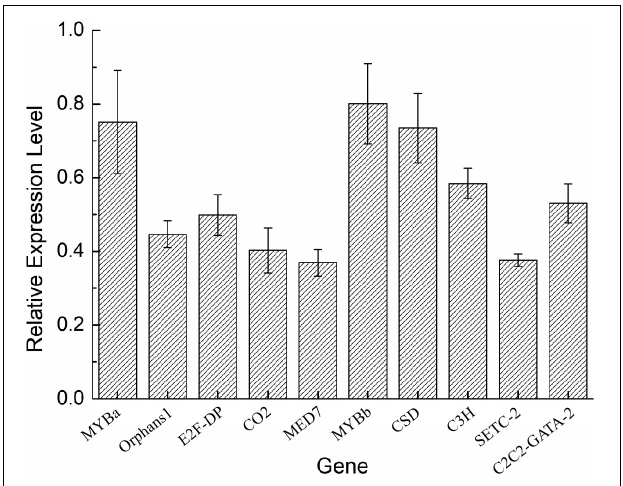
FIGURE 6 | Analysis of downregulated DETFs by quantitative reverse transcription (qRT)-PCR.